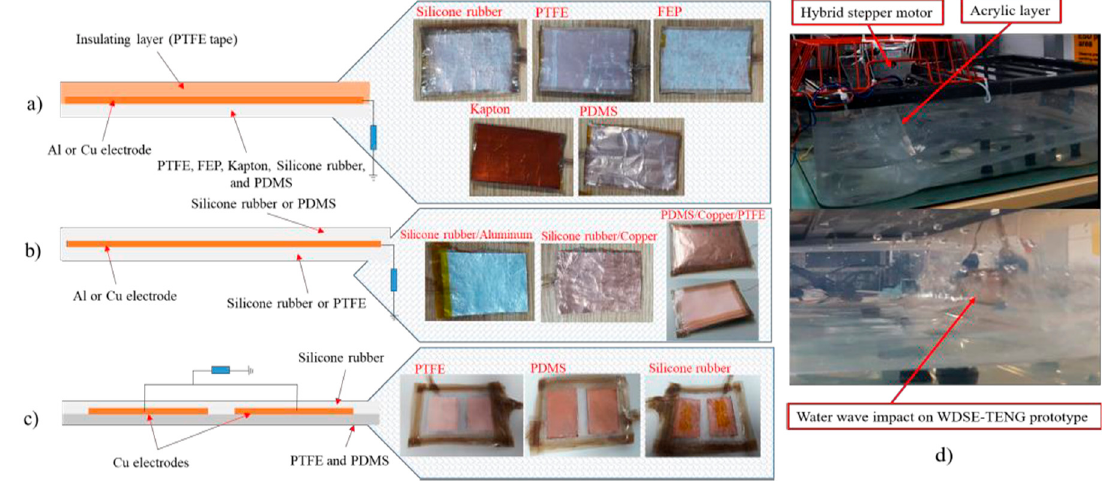
Figure 1. Three configurations of fabricated WDSE-TENG prototypes ( a ) WDSE-TENG with one dielectric layer, ( b ) full device covered with two dielectric layers, and ( c ) split single electrode-two dielectric layers in contact with water. ( d ) WDSE-TENG prototypes placed on the water wave generator tank for their output performance measurements on water